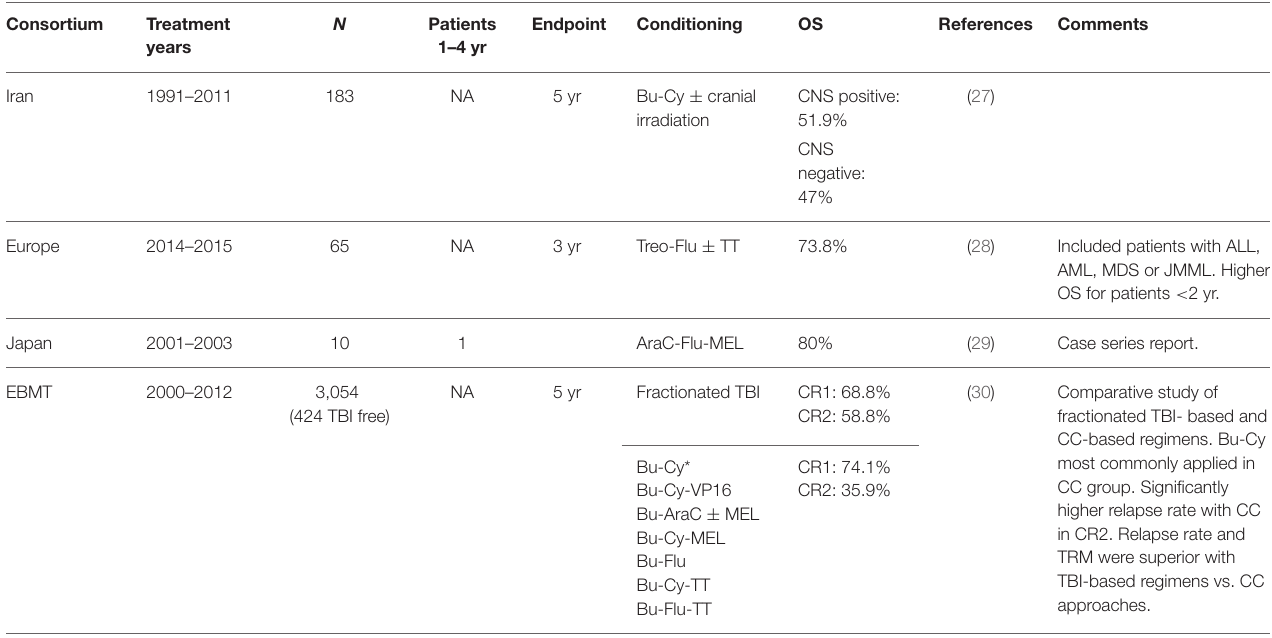
TABLE 3 | Outcome of transplantation after conditioning regimens based on chemotherapy only in children with ALL.